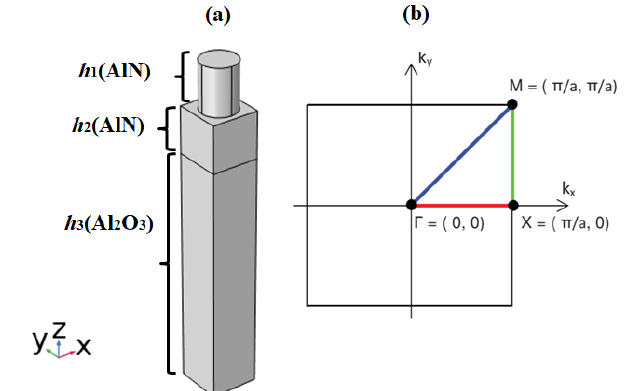
Figure 5. ( a ) PnC unit cell used for the dispersion curve calculation. ( b ) First irreducible Brillouin zone.